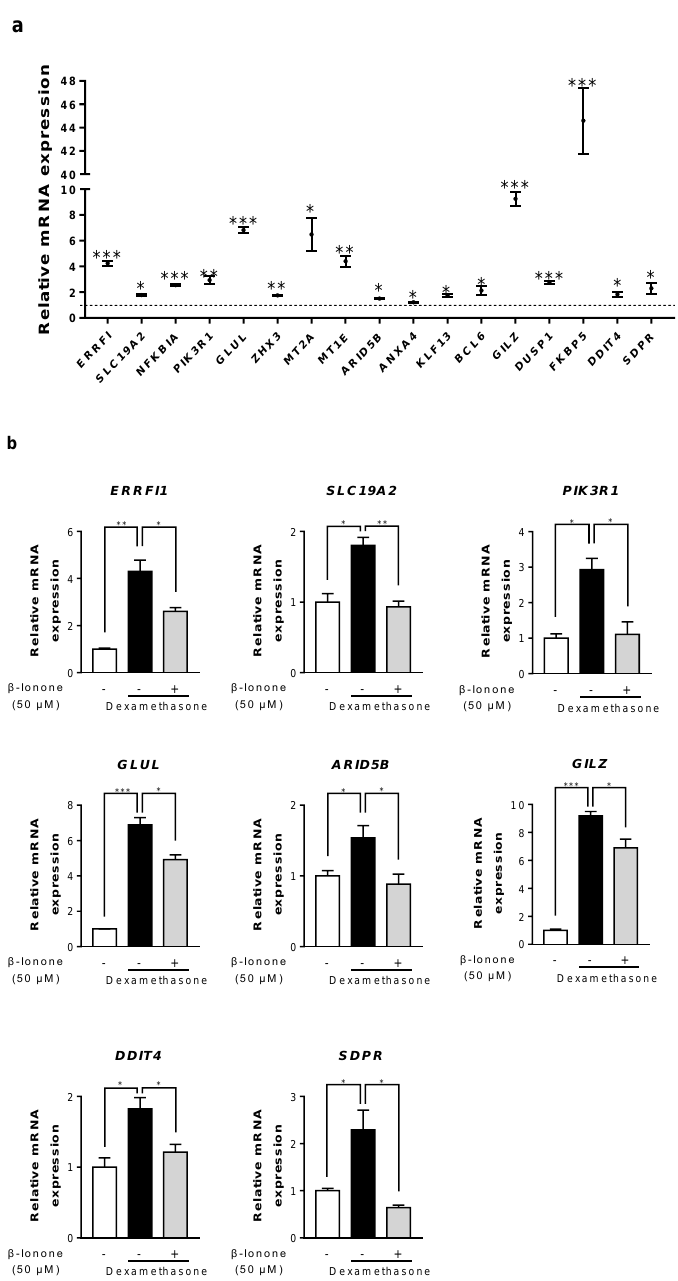
Figure 6. β -ionone suppresses dexamethasone-induced GR target genes in human dermal fibroblasts. Human dermal fibroblasts were treated with either vehicle (shown as “-”) or β -ionone (shown as “+”) as well as dexamethasone for 12 h. Total RNA samples were prepared and analyzed by quantitative RT-PCR. ( a , b ) The mRNA expression of well-known glucocorticoid-responsive genes (ErbB receptor feedback inhibitor 1, ERRFI1 ; solute carrier family 19 member 2, SLC19A2 ; nuclear factor kappa B inhibitor alpha, NFKBIA ; phosphoinositide-3-kinase regulatory subunit 1, PIK3R1 ; glutamate-ammonia ligase, GLUL ; zinc fingers and homeoboxes 3, ZHX3 ; metallothionein 2A, MT2A ; metallothionein 1E, MT1E ; AT-rich interaction domain 5b, ARID5B ; annexin A4. ANXA4 ; kruppel- like factor 13, KLF13 ; B-cell lymphoma 6, BCL6 ; glucocorticoid-induced leucine zipper, GILZ ; dual specificity phosphatase 1, DUSP1 ; FK506 binding protein 5, FKBP5 ; DNA damage inducible transcript 4, DDIT4 ; and serum deprivation-response protein, SDPR ) was evaluated. Values are shown as mean ± standard error of the mean (SEM) of three experiments. Statistical significance is expressed as follows: * p < 0.05, ** p < 0.01, *** p <